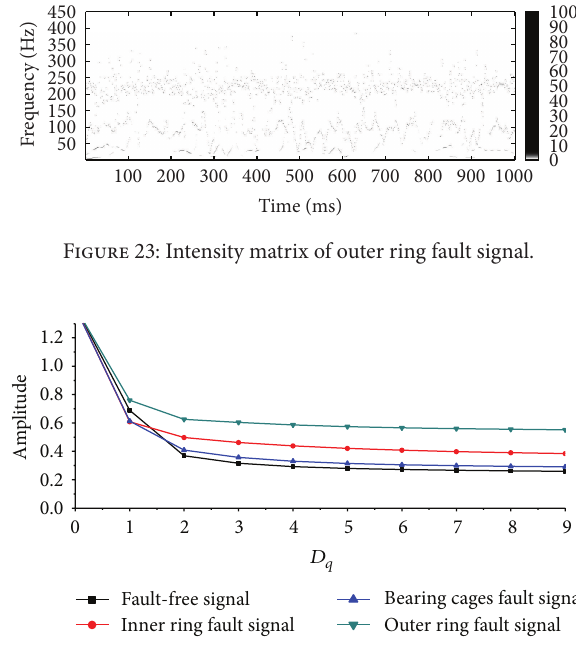
Figure 24: The generalized dimension curve of four experimental